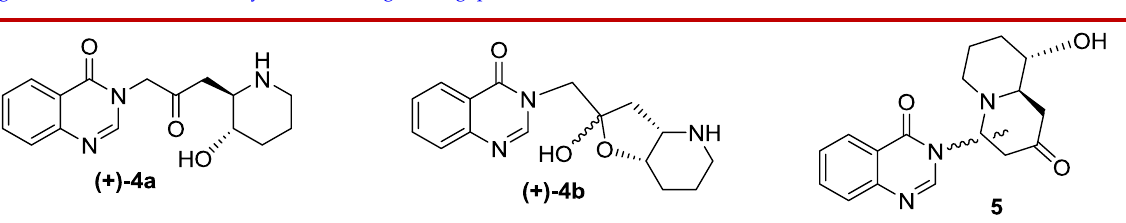
Figure 1: Selected commercially available drug bearing quinazoline core